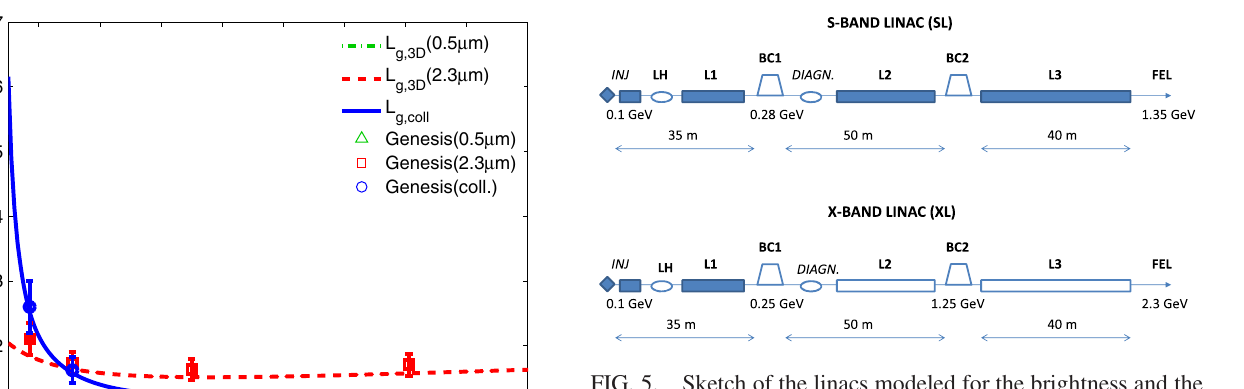
factor.FIG. 5. Sketch of the linacs modeled for the brightness and the gain length study (not to scale). Filled rectangles are for S -band rf structures; empty rectangles are X -band. Labels in bold refer to elements modeled in this